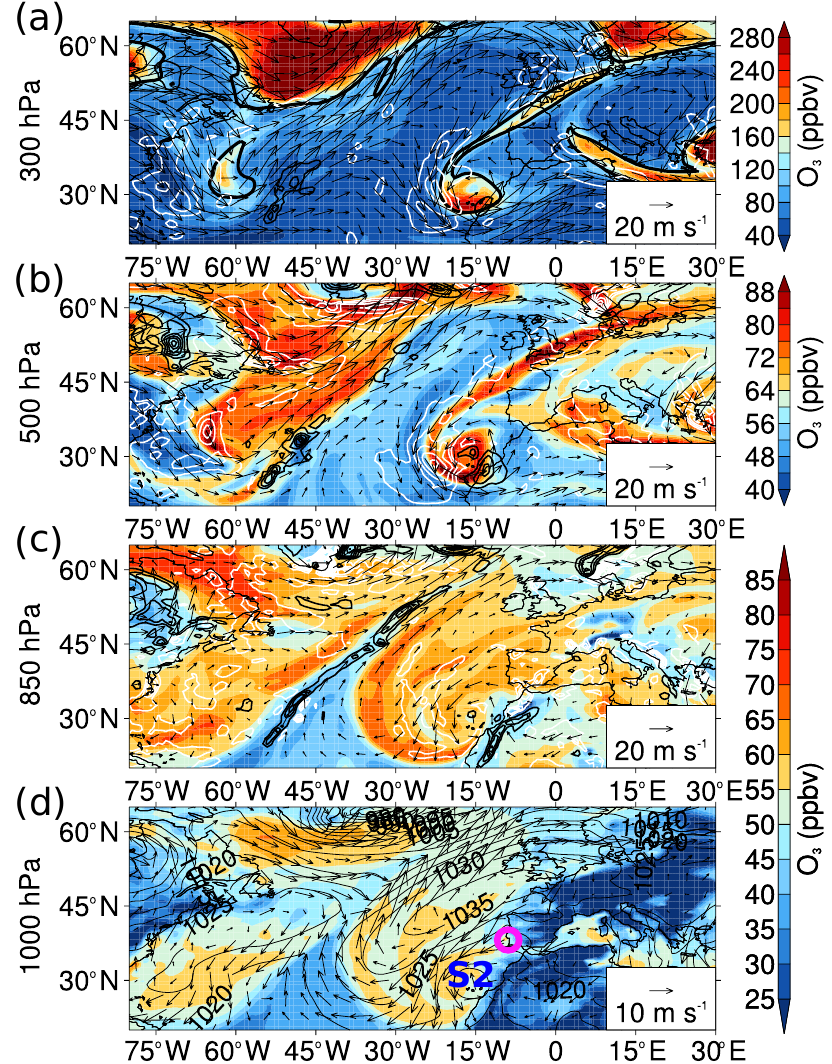
Figure 13. Synoptic conditions for the S2 cyclone ( d ; 31 ◦ N, 17 ◦ W) on the 13 March 2007 at 18:00UTC, at the time of maximum ζ 850 . O 3 (color; note different scales used for different levels) and horizontal winds (note magnitude of reference arrow changes) are shown on four levels: (a) 300hPa, (b) 500hPa, (c) 850hPa, and (d) 1000hPa. In addition, MSLP ( d ; solid contours, 5hPa intervals), ω ( a , b , and c ; 5hPah − 1 contour intervals, black contours for positive values indicating ascent (NB: different interval to previous cyclones) and white contours for descent), and 2PVU isosurface ( a ; thick contour) are shown. Monte Velho indicated by pink open